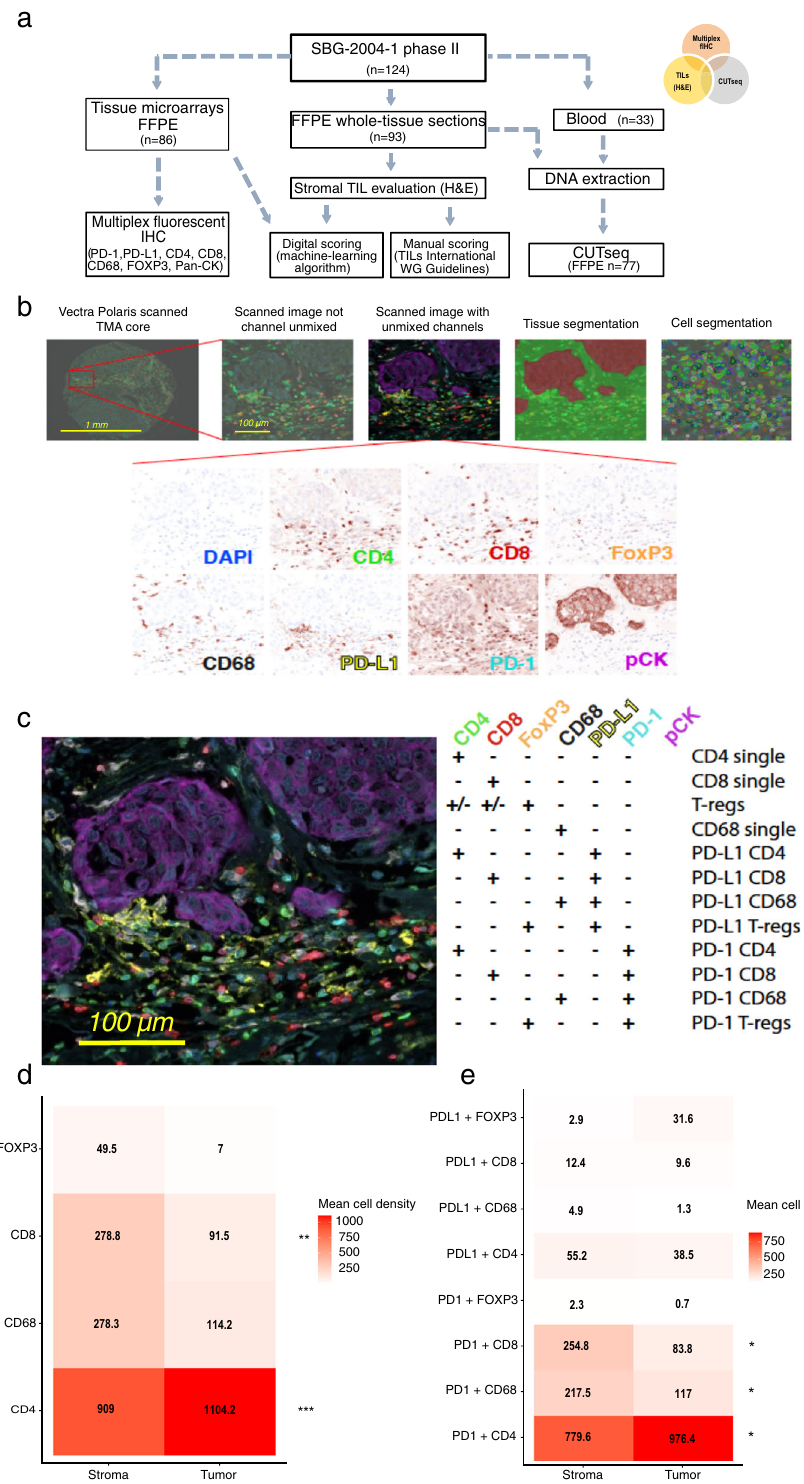
Fig. 1 Immune pro fi ling using a multiplexed method in early breast cancer formalin- fi xed paraf fi n-embedded (FFPE) tissue. a Flowchart of the patient sample availability and methods used in the translational sub-study of the SBG-2004-1 early breast cancer trial; b Overview and work fl ow of the multiplex fl uorescent IHC approach in tissue microarrays; c Representative image of the spatial immune cell distribution and phenotyping according to the (co)expression of the relevant markers; d , e Heatmaps depicting mean cell densities of immune cell subpopulations and expression patterns per tissue compartment ( n =